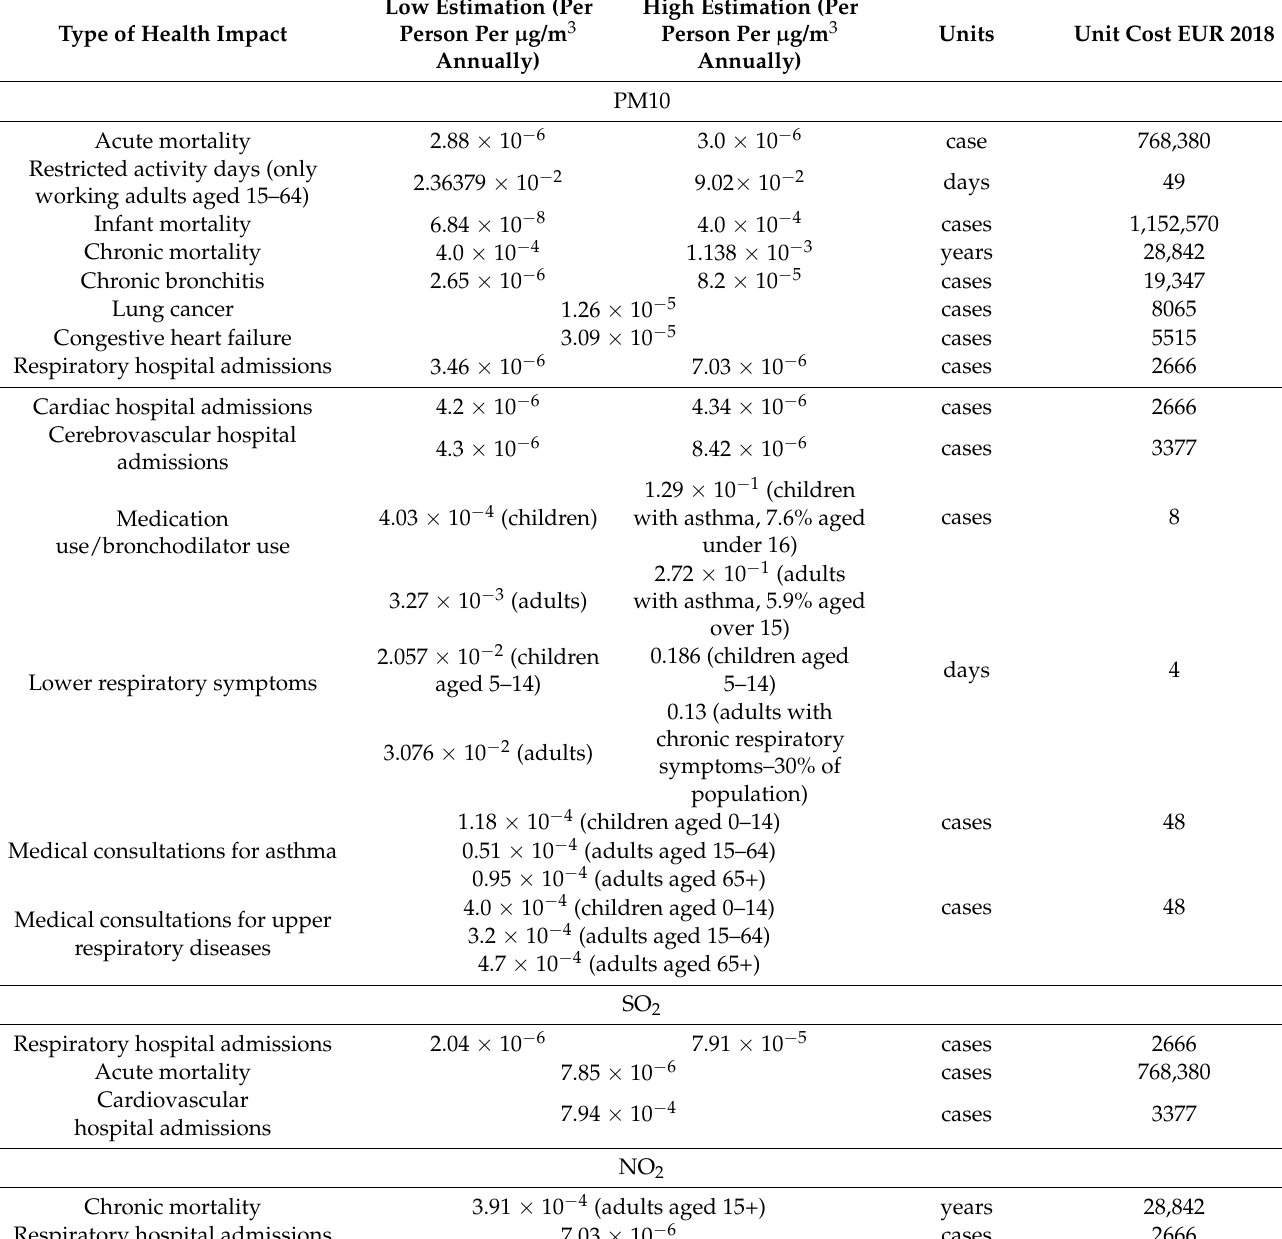
Table 3. The concentration–response function (CRF) used in the two cases (low and high estimation). Costs given for Poland in 2018 in EUR 2018. Based on the data presented in Table